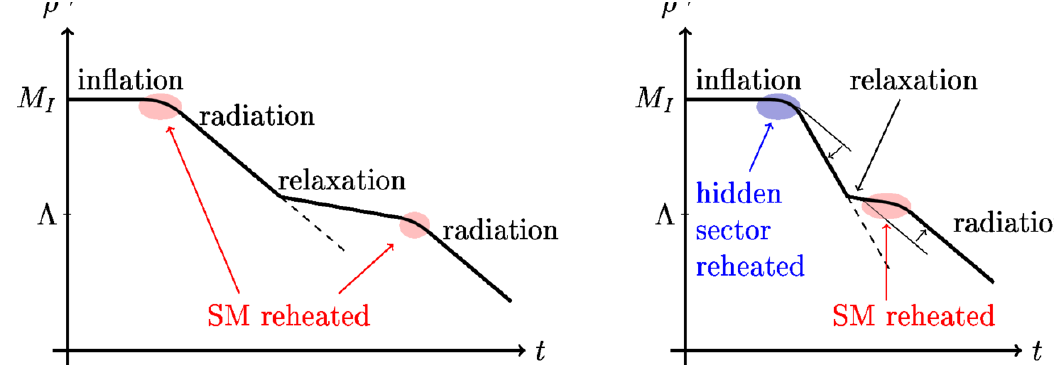
Figure 2 . Sketch of the evolution of the energy density of the universe under two distinct assump- tions about the (cid:12)rst reheating stage. Left: the in(cid:13)aton reheats the visible sector, and relaxation starts when its temperature drops below (cid:3). The period of relaxation is characterised by a short stage of in(cid:13)ation lasting for a few e-folds as needed to suppress the thermal mass of the Higgs. A second reheating takes place after relaxation. Right: the in(cid:13)aton transfers its energy to a hidden sector, and the visible one is reheated after relaxation. In this case, the relaxation phase can be short, and some mechanism to dilute the dark radiation is needed. For example, a period of kinetic energy domination in the dark sector or a prolonged reheating phase with a matter-like equation of state can be su(cid:14)cient to suppress the dark component with respect to the visible one. energy is converted into radiation. A sketch of how the energy density evolves is shown in the left panel of (cid:12)gure 2. During the relaxation era, the equation of state changes along the evolution, with w = p=(cid:26) < 0 and close to w = (cid:0) 1 (cosmological constant) for the lowest values of the coupling g 0